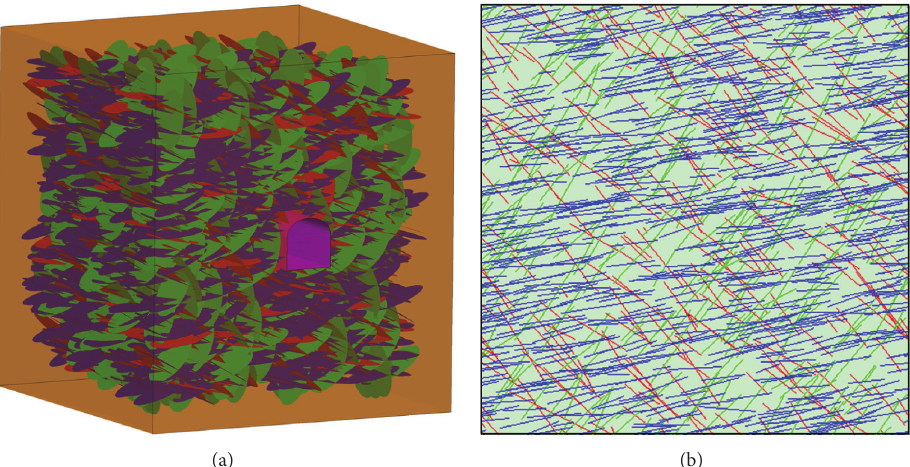
Figure 9: Joint network based on the statistical data using Monte Carlo method. (a) 3D joint network in rock mass; (b) profile with 10m edge length perpendicular to the roadway.